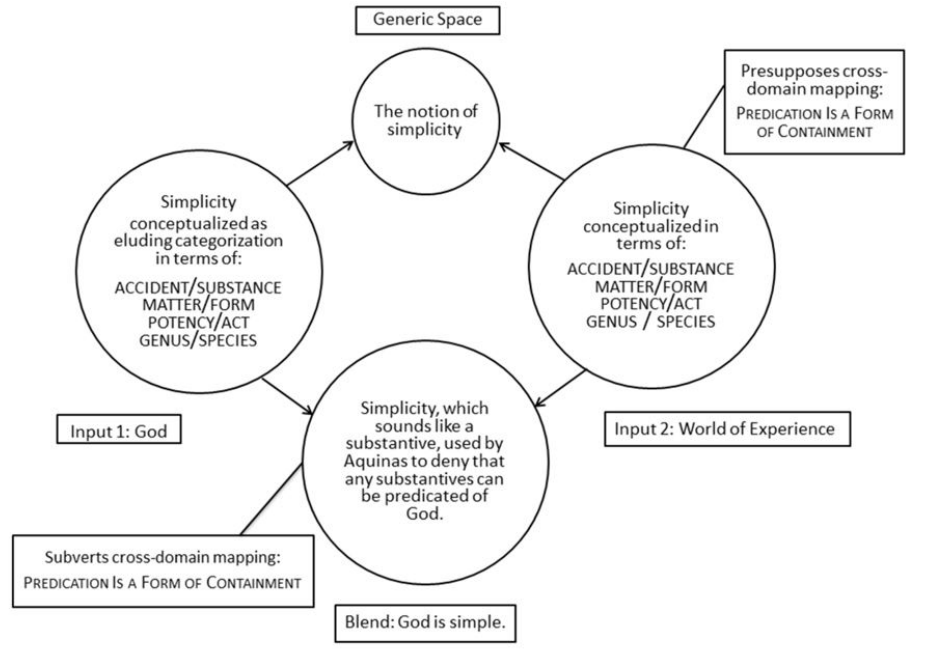
Figure 6: Cognitive mapping of Aquinas‘s blend: God is